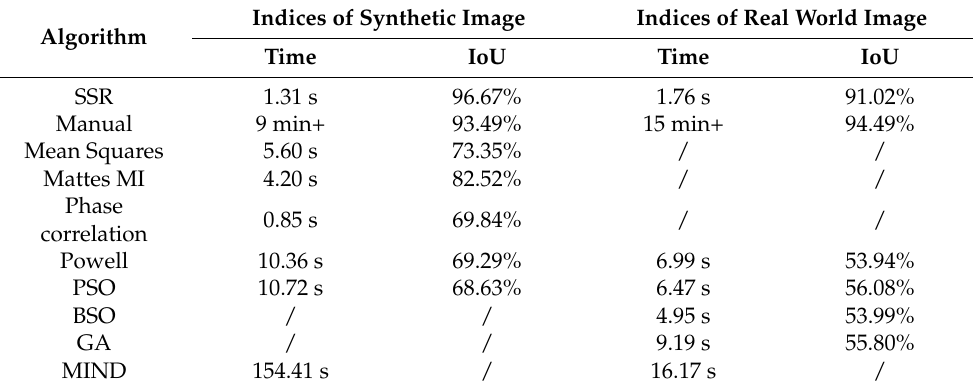
Table 3. Indices of intensity-based registration experiment.